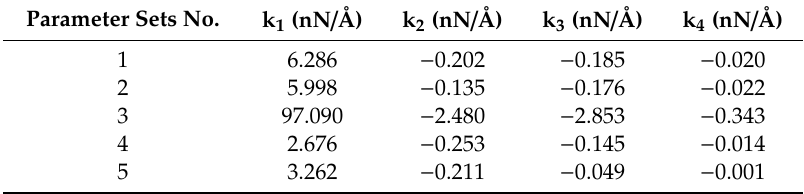
Table 2. E ff ective spring constants of the 1st to 4th nearest neighbor atoms utilized in ACM-based FEA. Parameter Sets No.